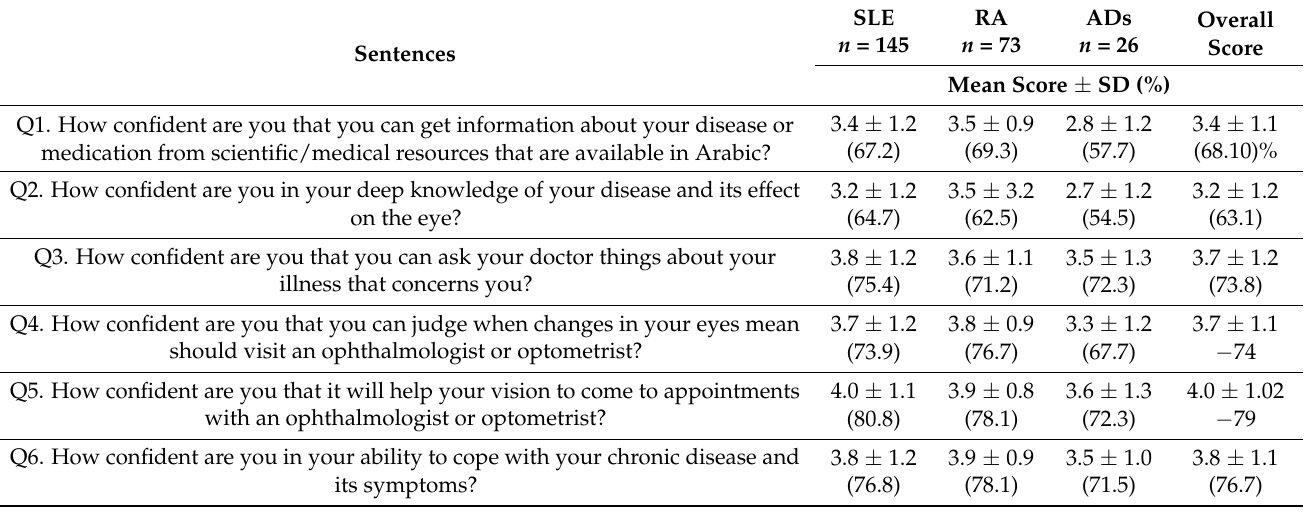
Table 3. Self-efficacy of patients with autoimmune diseases. Score obtained from 5-point Likert scale (%), n =